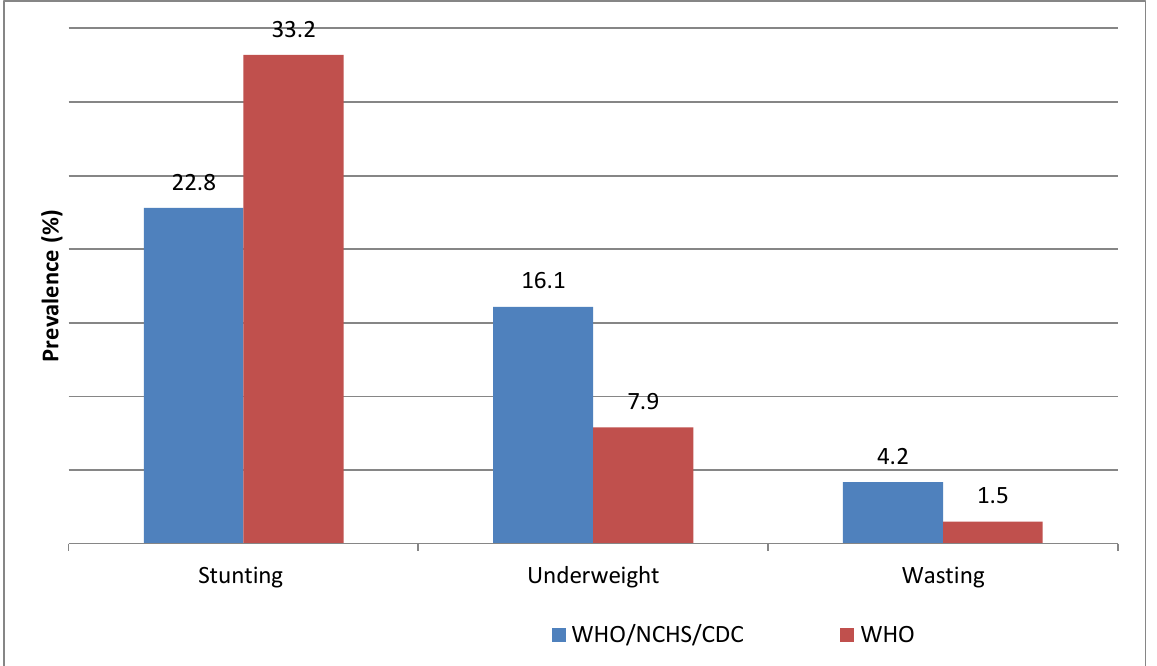
Figure 2. Prevalence of stunting, underweight and wasting in Mexican migrant children (<5 years old) from Northwest Mexico using the WHO/NCHS/CDC (1970’s) and the WHO child growth standards